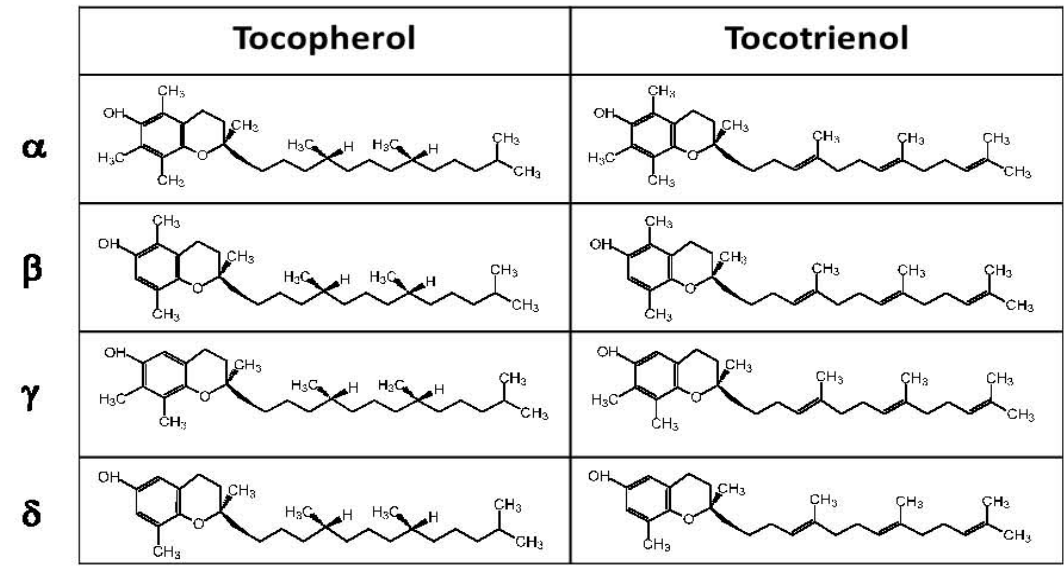
Figure 1. Tocopherols and tocotrienols. The isoforms differ in the number of methyl groups on the chromanol head group. The α -tocopherol isoform is the most abundant in tissues because of preferential transfer of α -tocopherol in the liver by α -tocopherol transfer protein ( α -TTP). The γ -tocopherol isoform is abundant in the diet but, in tissues, γ -tocopherol is 10 fold less abundant than α -tocopherol. The other forms of tocopherols and tocotrienols are less abundant in the diet and in tissues than α -tocopherol and γ